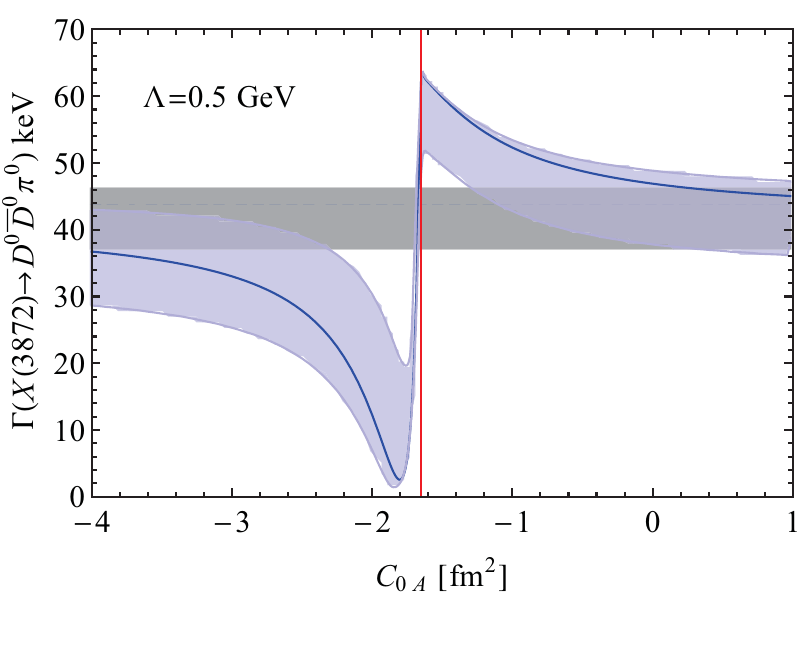
Figure 3. Same as figure 2 but for Λ = 1